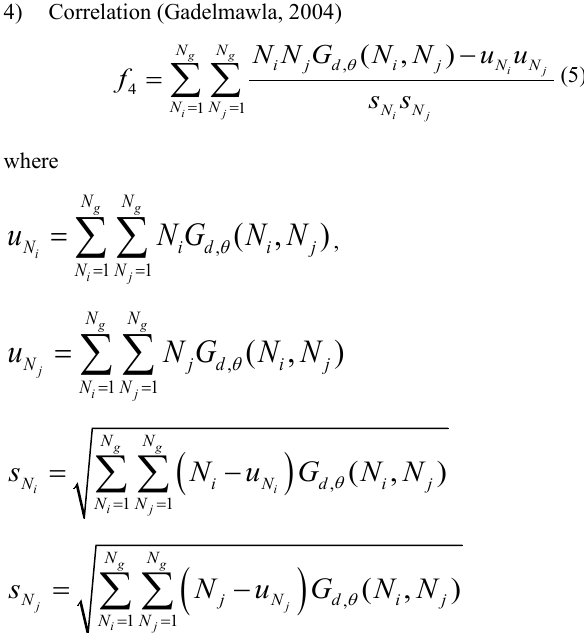
The correlation measures the consistency of image texture, reflecting the similarity of elements of GLCM in row or column direction. When the matrix element values are equal, the correlation value is large; on the contrary, if the matrix pixel values differ greatly, the correlation value is small. If there is